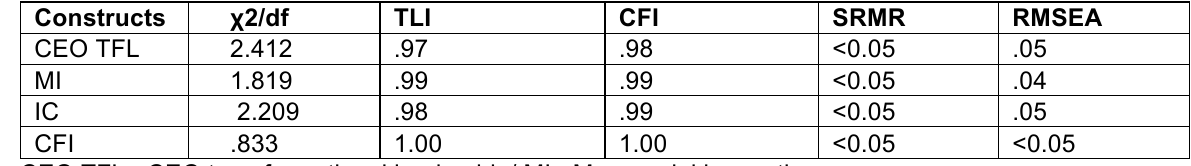
Table 1: Validity and reliability of the